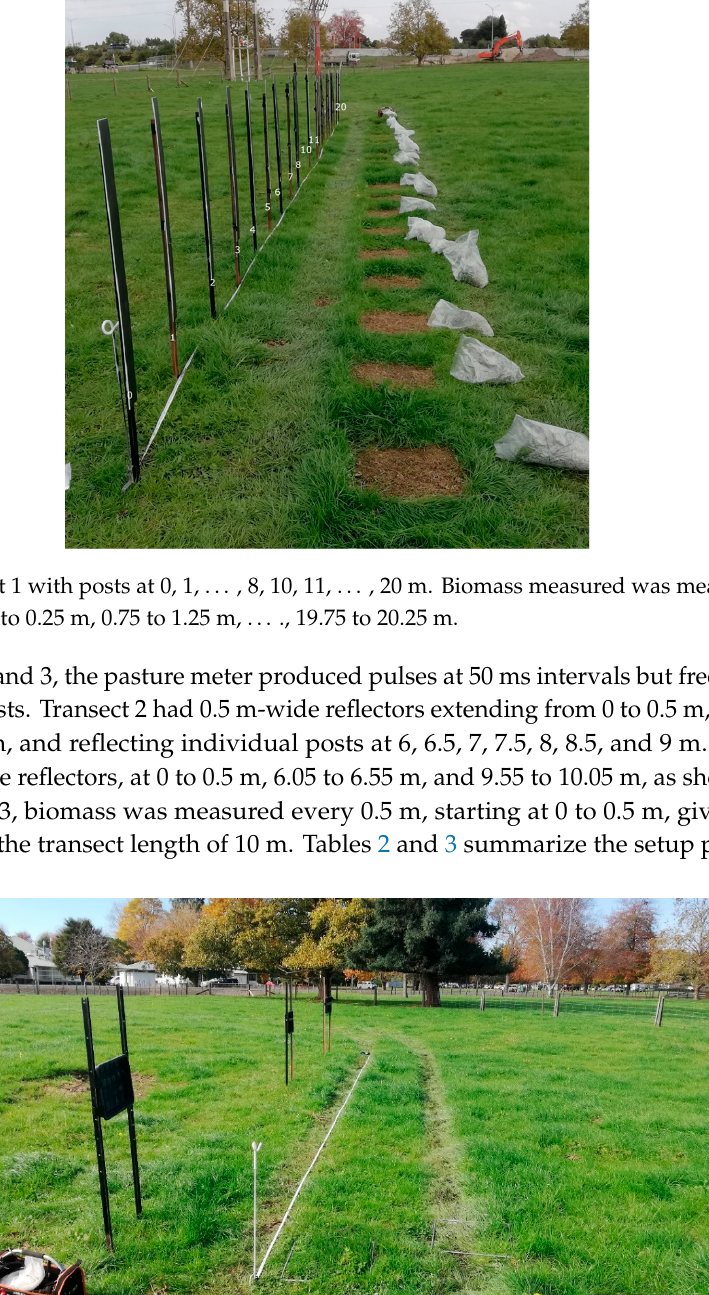
Figure 7 . Transect 3 with three 0.5 m-wide reflectors. Ultrasonic profiles and biomass samples were taken from the start of the first post up to the last post. The 0.5 m × 0.5 m quadrat frames can be seen.